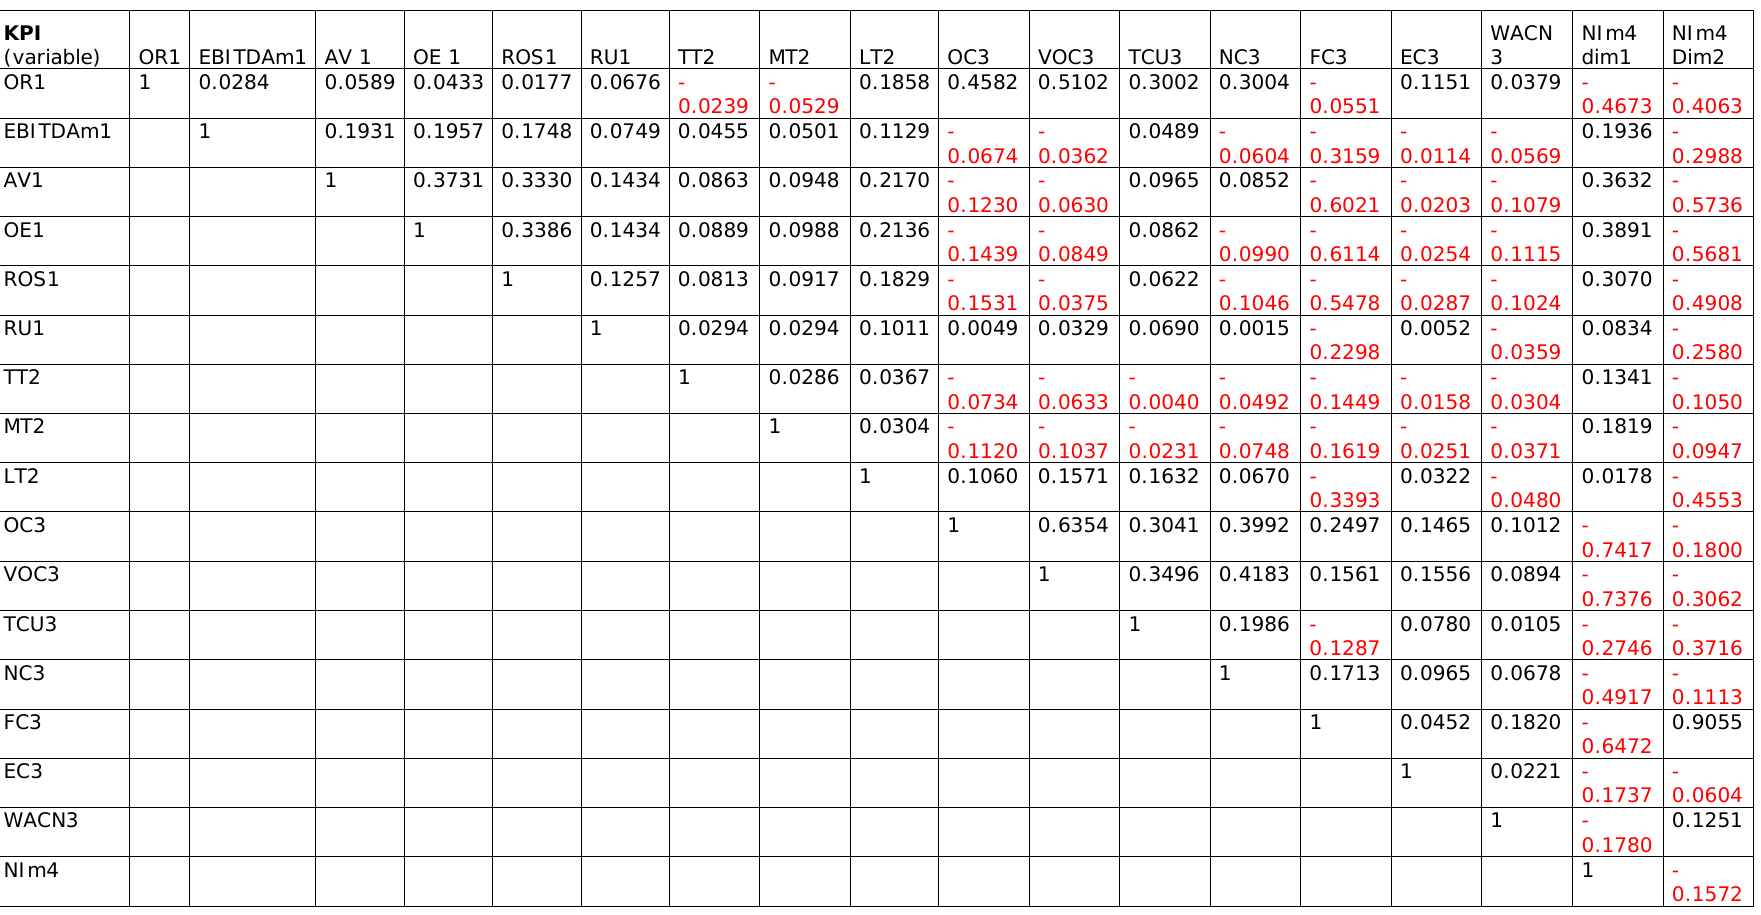
Table 7. “Correlation Matrix 2007 (Numerical & Multiple Nominal), Note: Abbreviations for variables are explained in Table